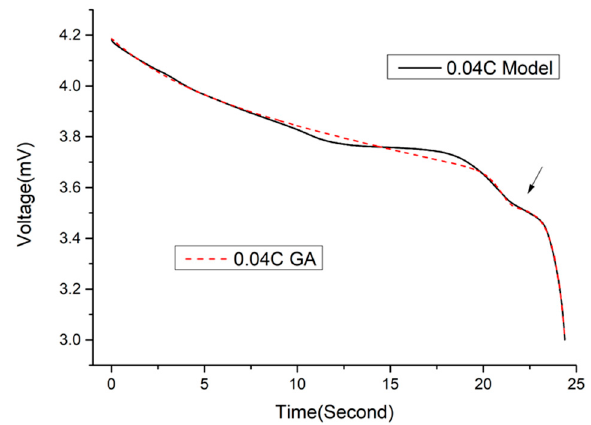
Figure 18. GA results 2 (L brand 18650).